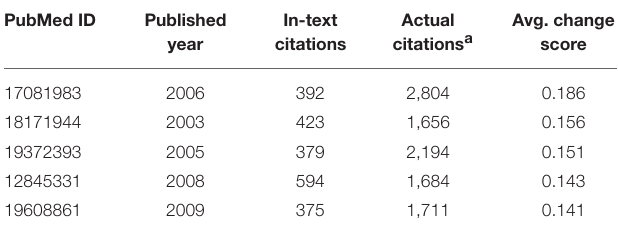
Frontiers in Research Metrics and Analytics |